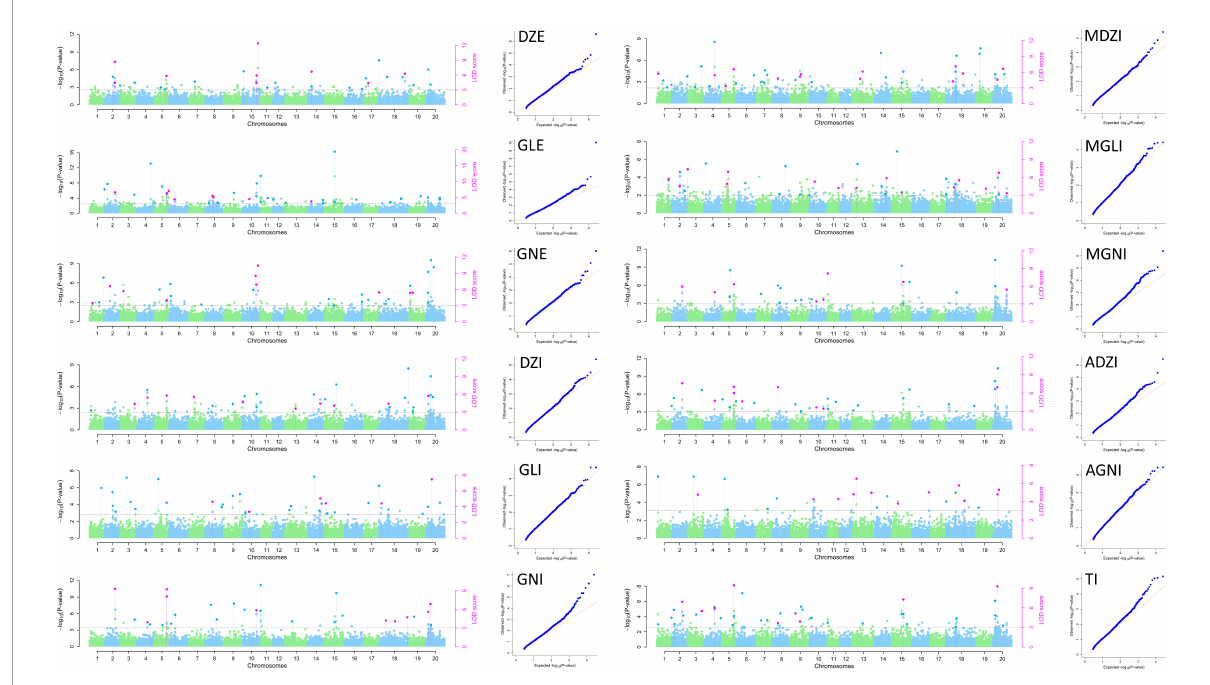
FIGURE3 Manhattan and QQ plots for isoflavone contents in 2020 in the MDP using MLM and mrMLM.